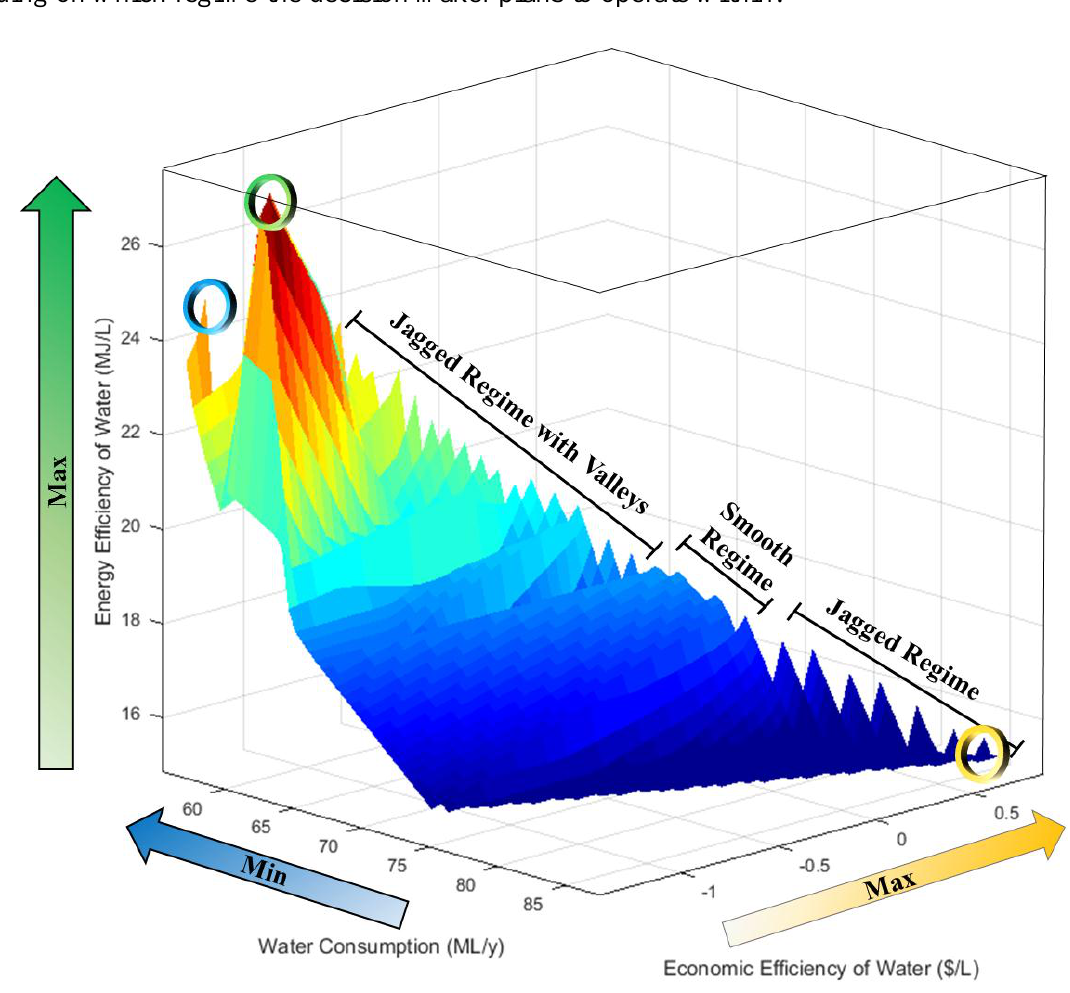
Figure 3. Pareto-optimal surface with key features and extreme points highlighted. The minimum water consumption solution is denoted with a blue circle ( far left ), the maximum energy efficiency of water solution is denoted with a green circle ( middle ), and the maximum economic efficiency of water solution is denoted with a yellow circle ( right